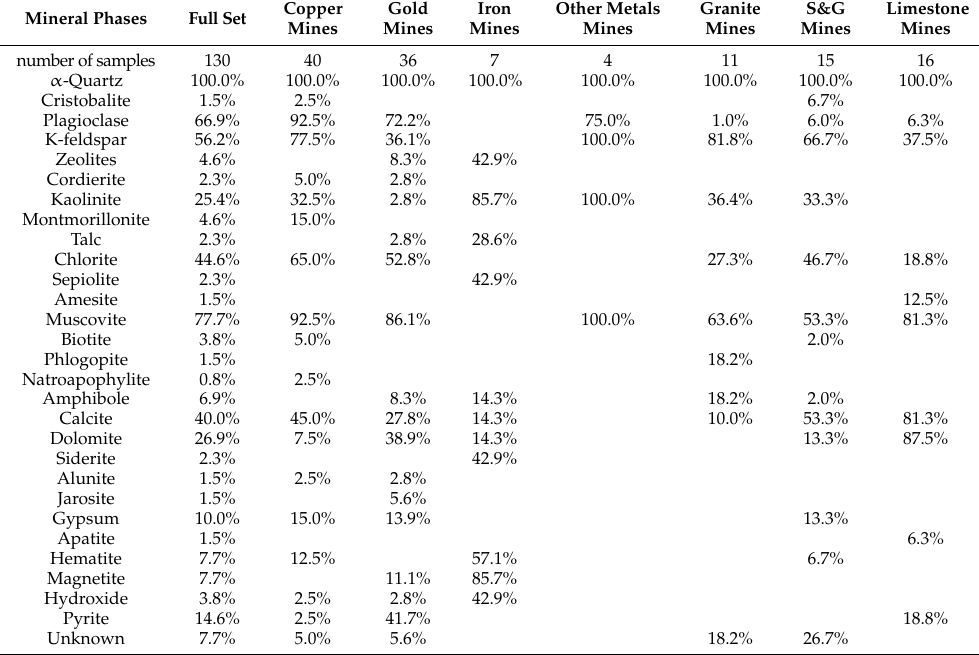
Table 1. Relative incidence of mineral phases in the 130 respirable mine dust samples organized by commodity.